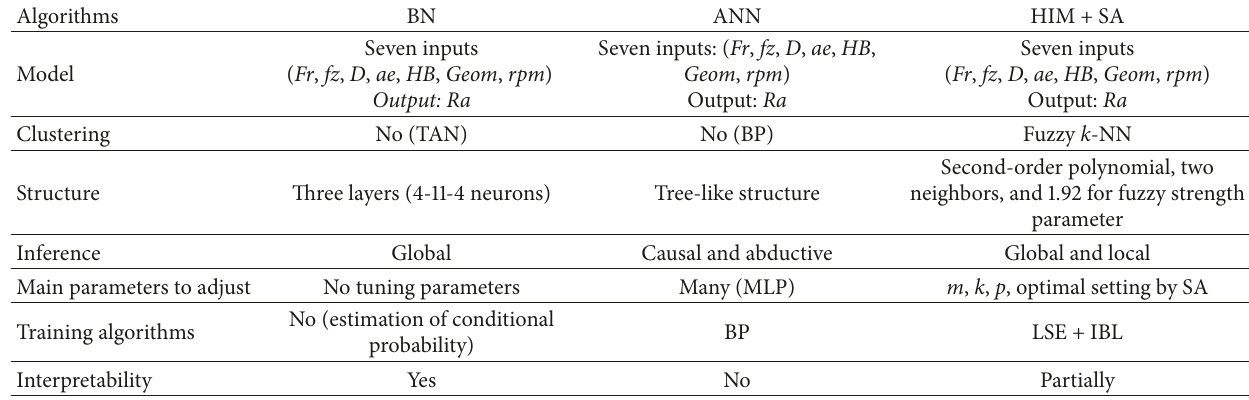
Table 4: Main parameters of each modeling strategy considered in this study.